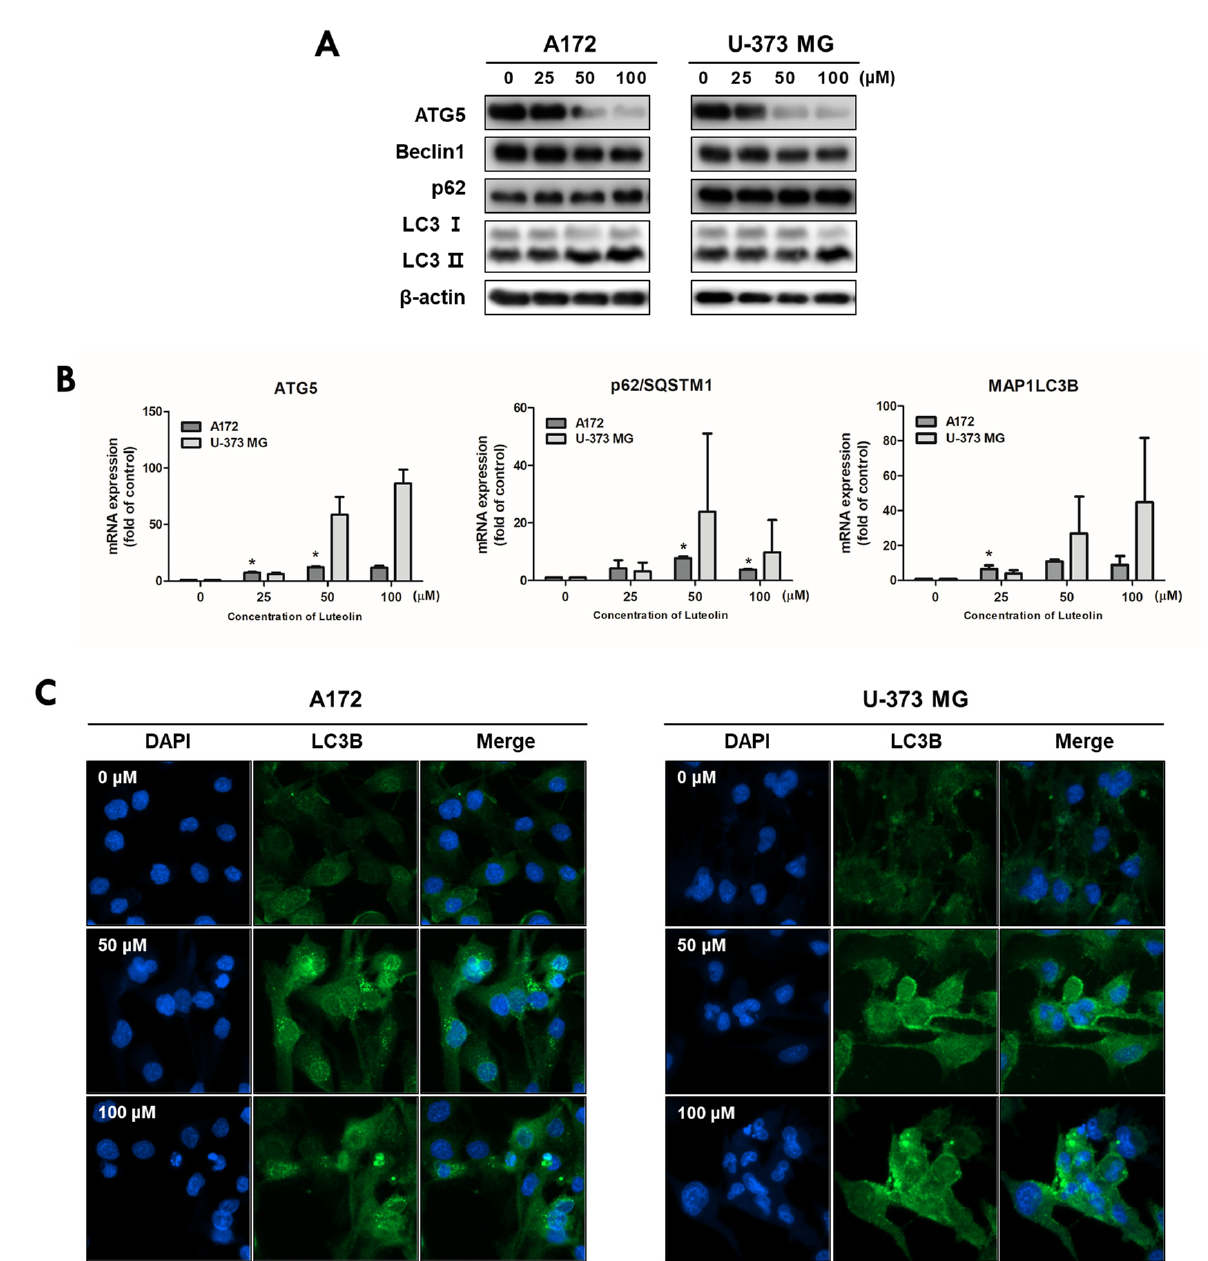
Figure 5. Luteolin regulates the autophagy-related factors in GBM cells. Luteolin treatment was applied at 0, 25, 50, and 100 µ M; after 24 h, the expression levels of proteins and genes were confirmed by Western blot assay ( A ) and qPCR ( B ) in A172 and U-373MG cells. β -actin protein was used as internal control. ( C ) Luteolin treatments were applied at 50 and 100 µ M in A172 ( A ) and U-373MG ( B ) cells, and LC3B expression was confirmed by immunofluorescence. Nuclei were visualized through DAPI staining (blue fluorescence) and LC3B staining with alexa488 (green fluorescence). The results are expressed as mean ± SD (* p < 0.05).